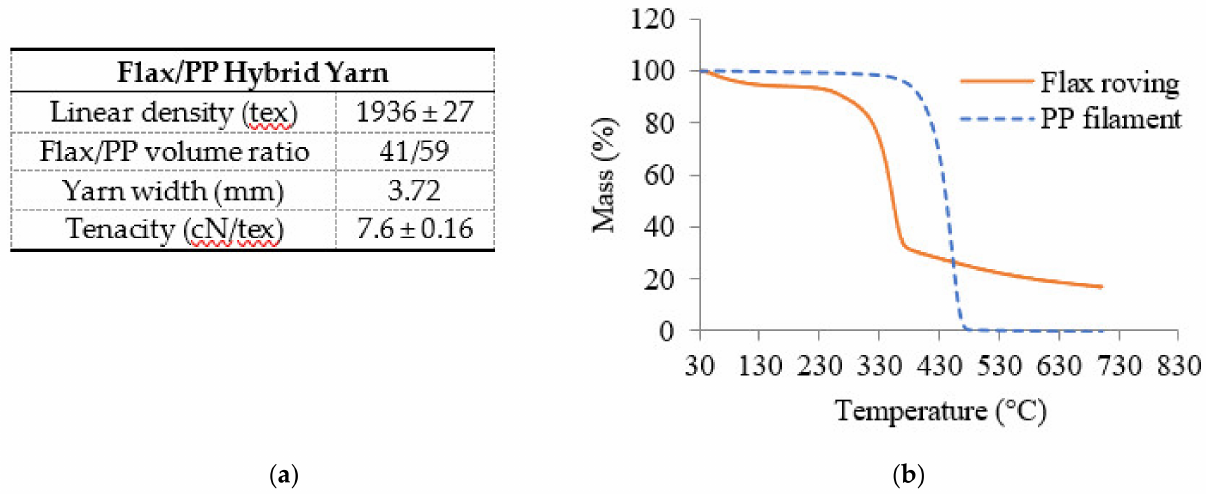
Figure 5. The raw material: ( a ) main properties and ( b ) TGA analysis. The 2D biaxial braided prepregs were manufactured by circular braiding loom with 96 bobbin tows carriers (Herzog GLH 1/97/96-100) at Gemtex laboratory, shown in Figure 6a. Based on the unit cell geometry, braiding process parameters as production speed and carrier rotational speed were chosen to obtain three different circular braided preforms [52]: BR-A, BR-B, and BR-C, as shown as Figure 6b. BR-A and BR-B possess the same braiding angle but a different tow waviness ratio and cover factor; BR-B and BR-C possess the same tow waviness ratio and cover factor but a different braiding angle. The circular braids BR-A and BR-C are wider than BR-B to facilitate comparative study, the unit cell width of BR-A and BR-C is equal by controlling the braiding process parameters.